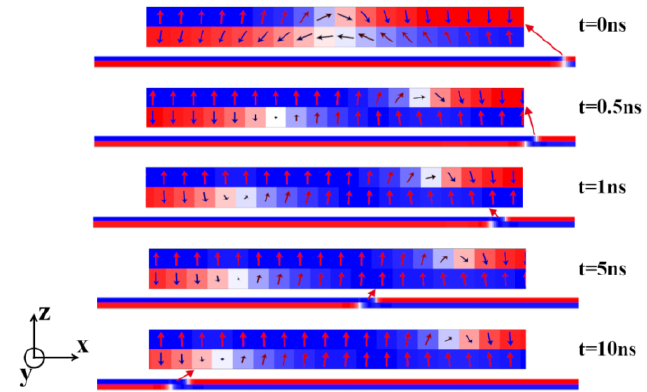
Figure 2. The representative snapshots of the position of the DW and the enlarged figures for the DW structure in the SAF racetrack memory at di ff erent times. The magnetic parameters of J ex , D, K U , and K L were fixed as − 0.15 mJ / m 2 , 0.75 mJ / m 2 , 5 × 10 5 J / m 3 , and 2.5 × 10 5 J / m 3 .